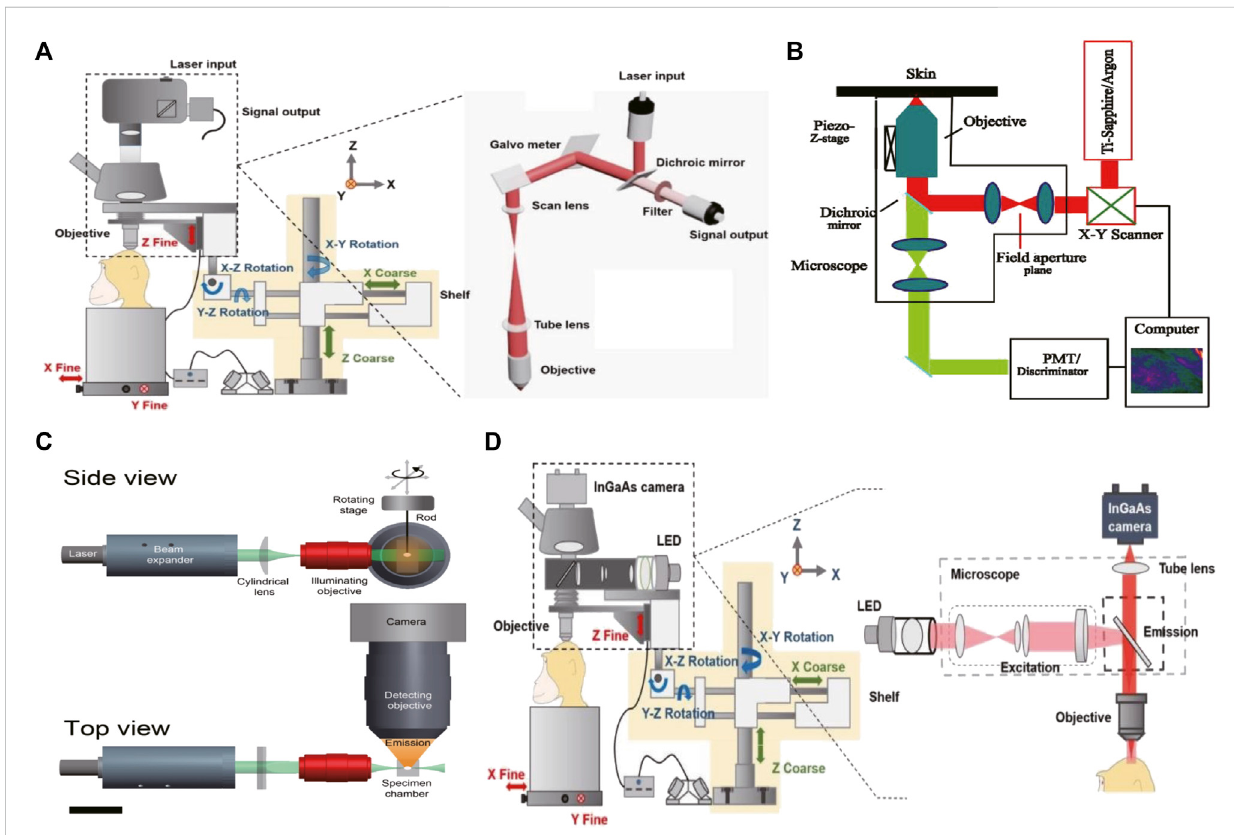
FIGURE 1 The schematic illustration of the NIR-II fl uorescence microscopic imaging system (A) . Schematic illustration of the confocal fl uorescence microscopic imaging system. Copyright Year 2020, Theranostics (Cai et al., 2020) (B) . Schematic illustration of the multiphoton fl